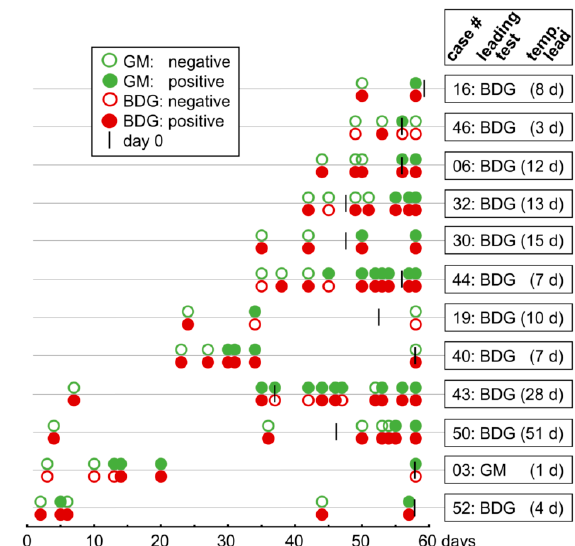
Figure 3. Comparison of seropositivity over the time course of infection. The time courses of twelve cases of proven/probable IA were plotted in which both tests were positive but seropositivity occurred at different time points (x-axis in days). Each case is displayed as separate line with green and red circles representing serum samples analysed with the galactomannan (GM) EIA and the β -1,3-D-glucan (BDG) assay, respectively. Empty and full circles indicate negative and positive measurement results, respectively. Black lines indicate the respective day 0 (day of proven/probable diagnosis of IA). Boxes at the right indicate the test which yielded positive results at the earlier time point and the temporal distance (in days) between the earliest dates of seropositivity of both assays, temporal.